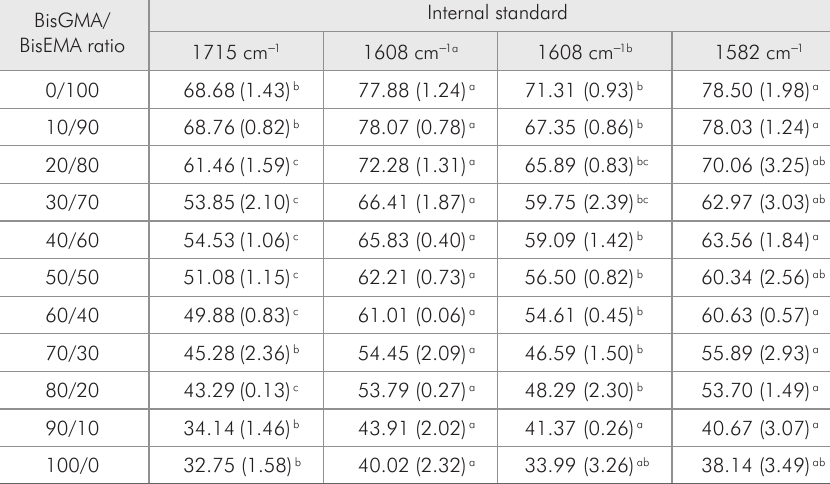
deviation) DC (%) for BisGMA/ BisEMA blends, measured using different internal standard